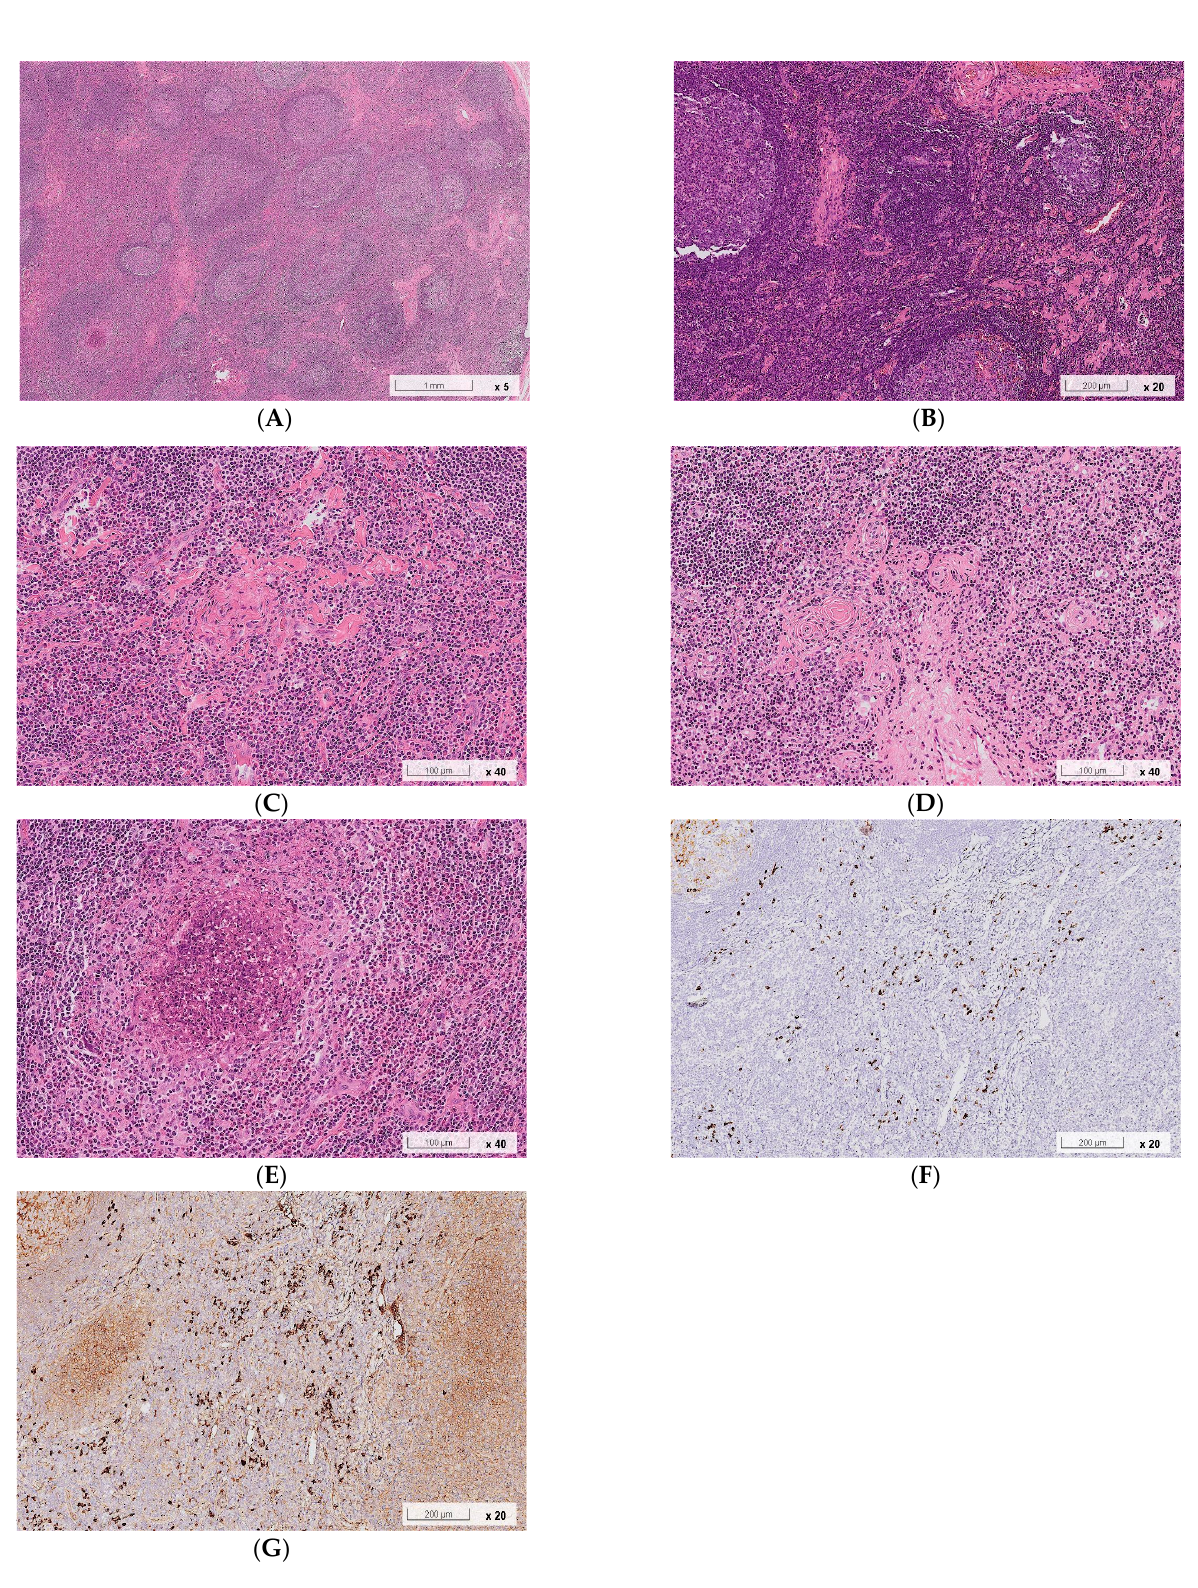
Figure 1. Pathological manifestations based on hematoxylin–eosin and immunohistological staining of the specimen obtained from Case 1. ( A ) Florid follicular hyperplasia, 5 × . ( B ) Small vessel infiltra- tion with fibrosis, 20 × . ( C ) Stromal fibrosis, 40 × . ( D ) Periventricular sclerosis, 40 × . ( E ) Eosinophilic infiltration with eosinophilic abscess formation, 40 × . ( F ) Immunohistological staining showed >50 IgG4(+) cells per high-power field. ( G ) Immunohistological staining showed IgG(+) cells.